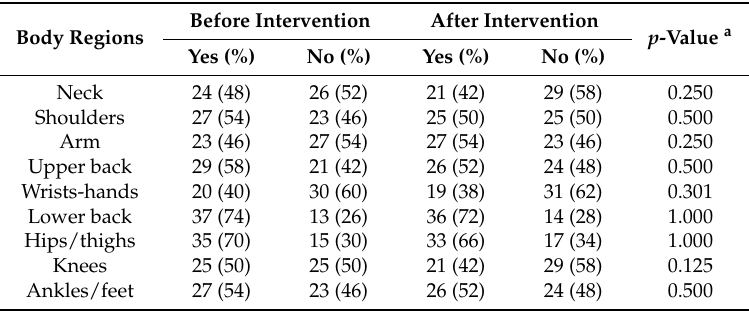
Table 3. Prevalence rates of reported MSDs in different body regions of control subjects before and after intervention ( n = 50).